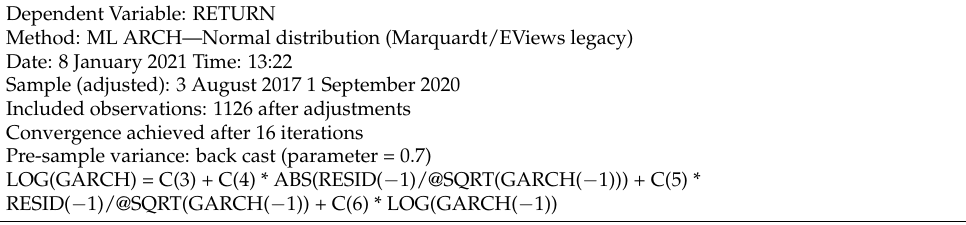
Table 10. Estimated Result of E-GARCH Model for Mexican Peso Return Index during